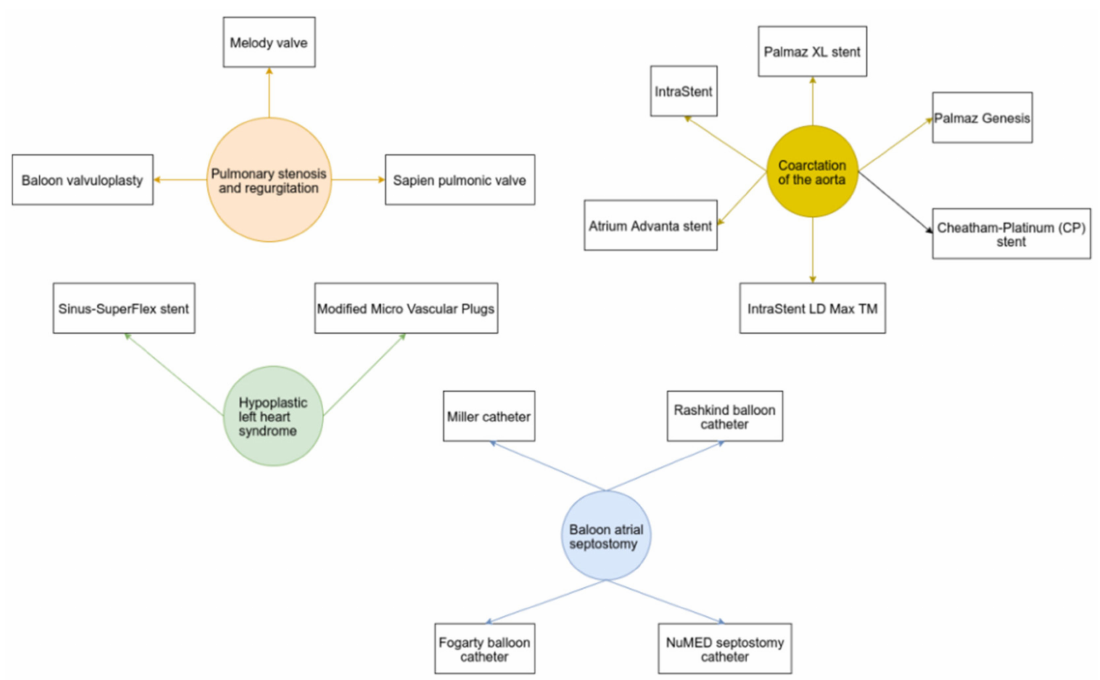
Figure 3. Devices used in various congenital heart